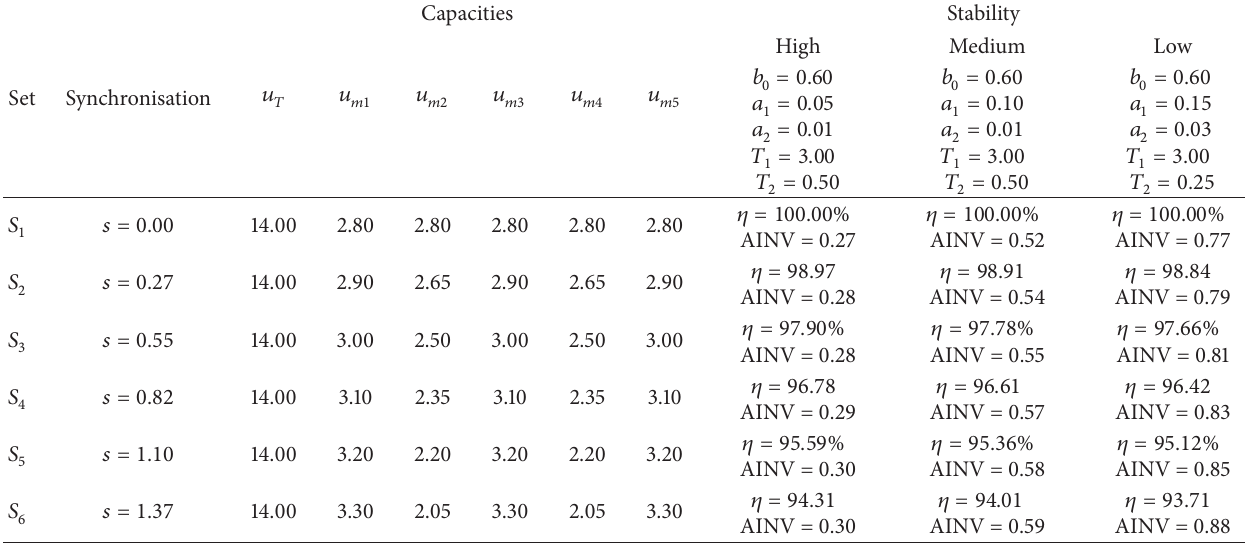
Table 2: Parameter settings and simulation results.